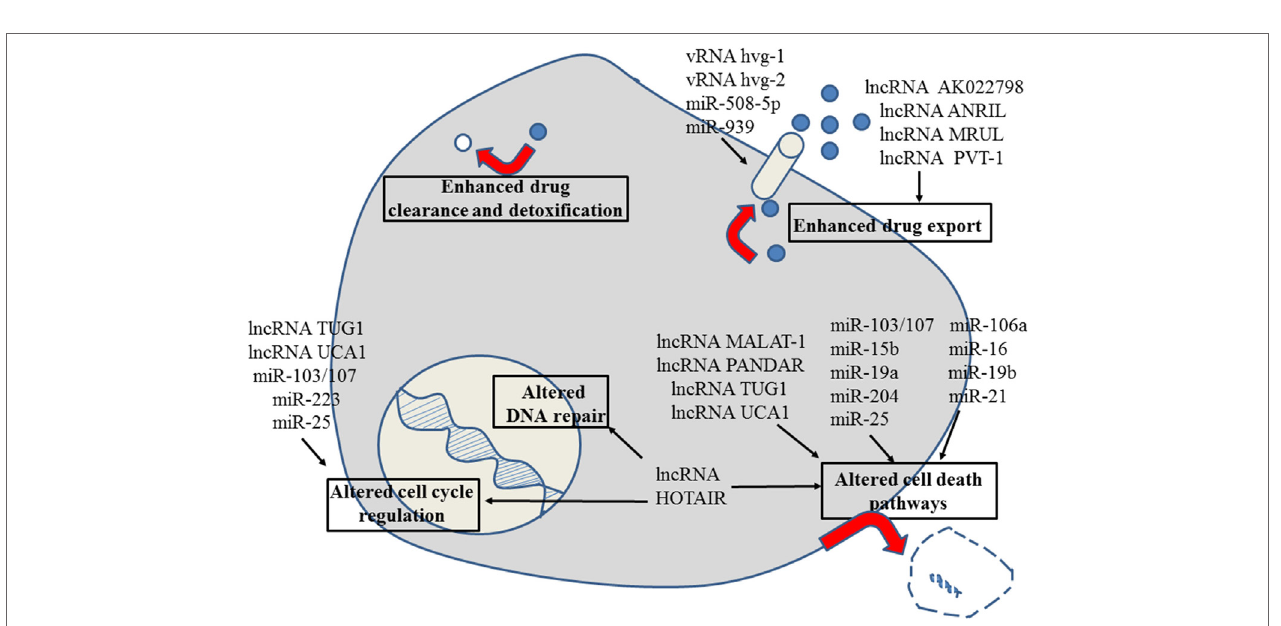
FiGURe 2 | Role of non-coding RNAs for the different reasons that can cause resistance to anticancer drugs in esophageal cancer. For details about target genes and regulated protein expression by the non-coding RNAs, see